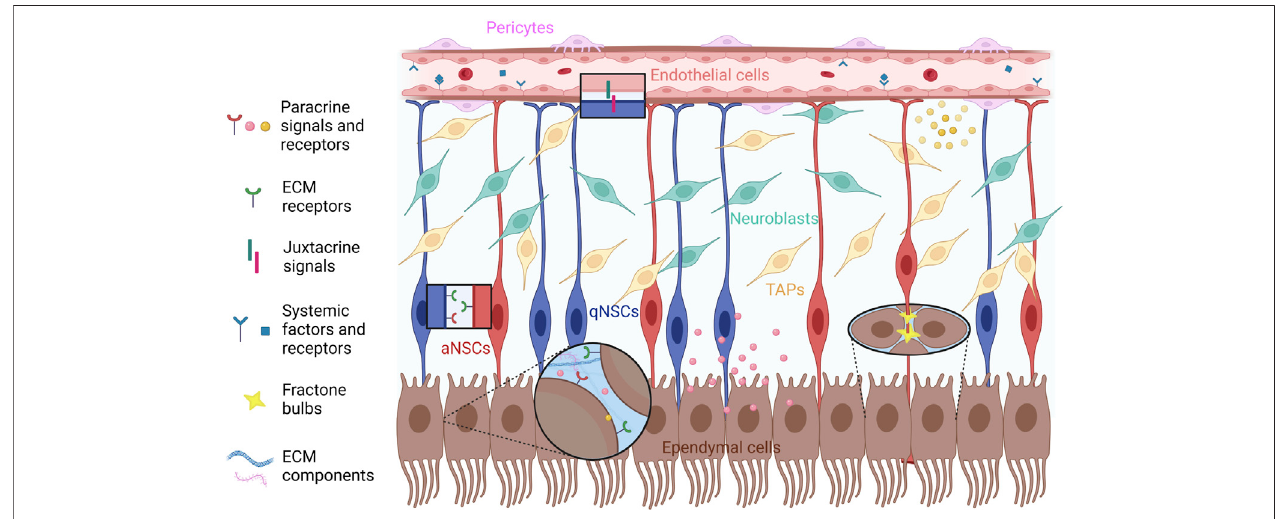
FIGURE 1 | Schematic representation of the cell types of the adult V-SVZ niche that are speci fi cally discussed in this review (qNSCs, aNSCs, TAPs, NBs, ependymalcells,endothelialcellsandpericytes),andthedifferenttypesofsignals(systemic,paracrine,juxtacrine,ECM-associated)involvedinthefunctionalinteractions among NSPCs, ependymal and vascular cells. The diagram does not include non-neurogenic astrocytes, oligodendrocyte precursors, microglia, neuronal cells and neuronal terminals, which are also present in the V-SVZ; moreover, it does not faithfully represent the relative location and distance from the apical and basal compartments of NSCs, TAPs and NBs. See text for further details. Created with